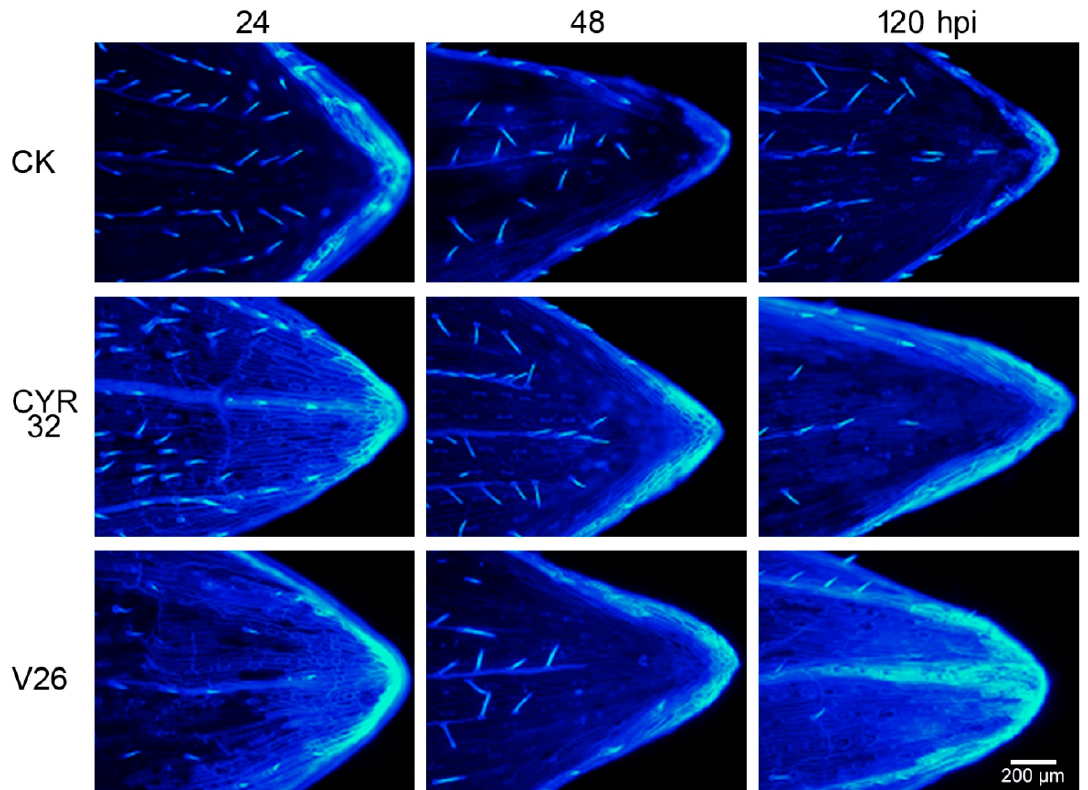
Figure 3. Callose deposition of wheat cultivar CM42 inoculated with CYR32 and V26. The un-inoculated and inoculated leaves were stained with aniline blue at 24, 48, and 120 hpi. The images are observed with the fluorescence microscope. Bars = 200 µm. CK, un-inoculated wheat plants. 24–120 hpi represent 24, 48, and 120 h post-inoculation.